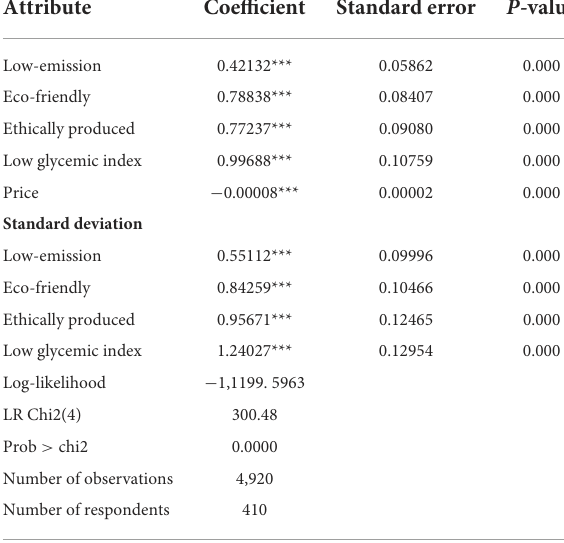
TABLE 6 Estimated results of mixed logit model for choice